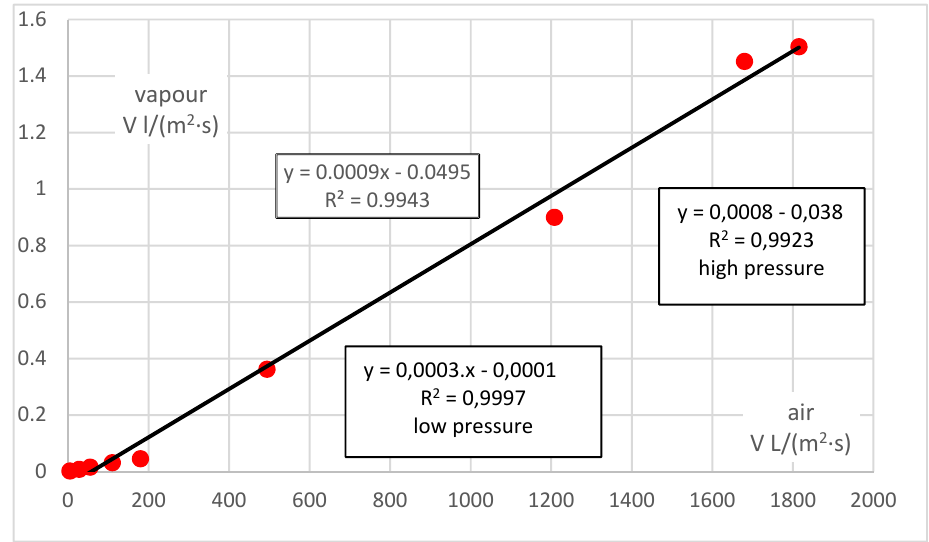
Figure 4. Correlation between vapour and air permeability rates—summary.